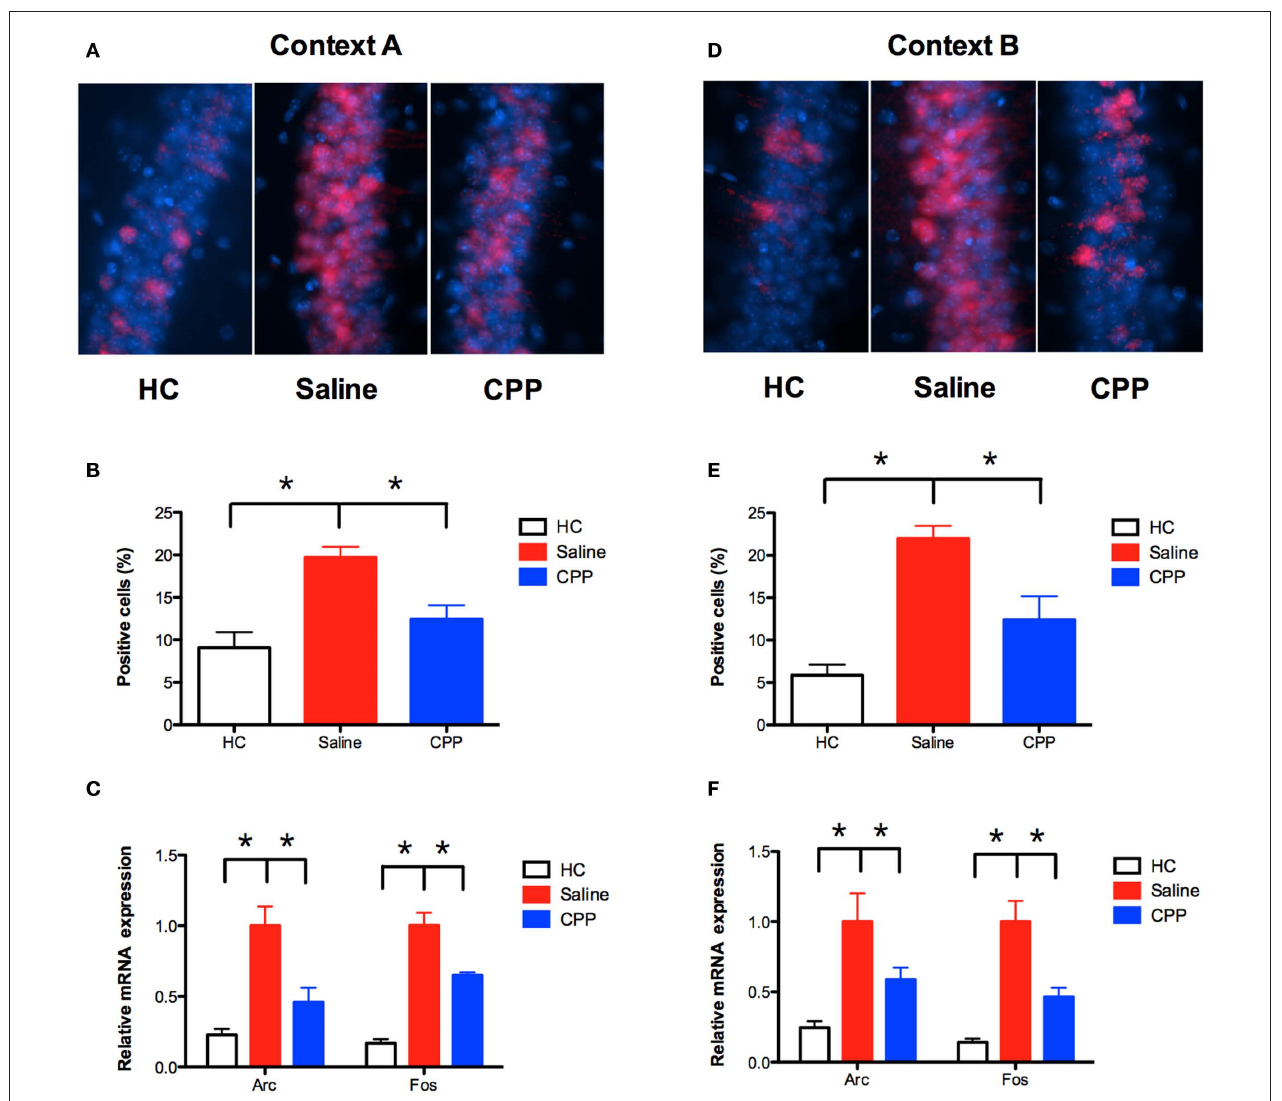
qRT-PCR. This effect was reduced by an injection of CPP ( n = 11) prior to training. (D,e) Mice trained in A, and context B 5 days later also demonstrated increased expression of Arc in CA1 ( n = 4) relative to homecage controls ( n = 2). This increase was reduced by an injection of CPP prior to training ( n = 5).